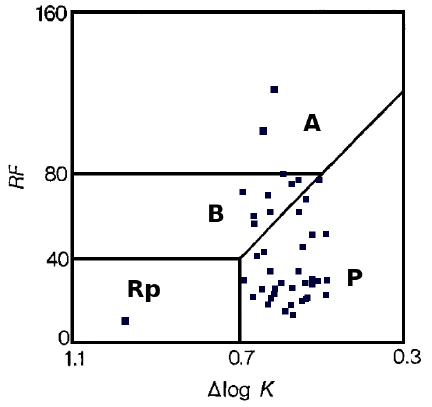
Figure 3. Classification of types of humic acids in mountain